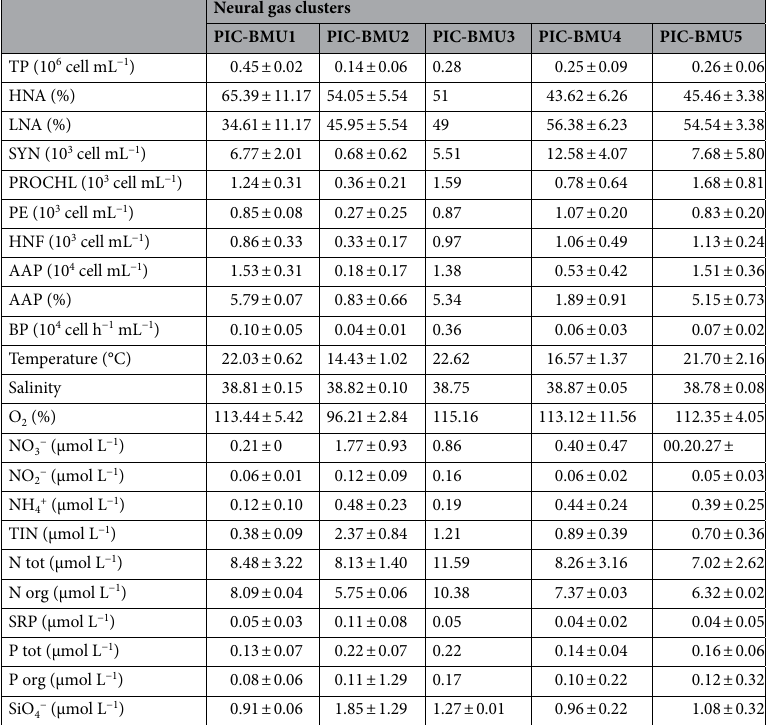
Table 1. Characteristics of biological (abundances of total prokaryotes-TP, Synechococcus -SYN, Prochlorococcus -PROCHL, picoeukaryotes-PE, heterotrophic nanoflagellates-HNF, aerobic anoxygenic phototrophs(AAP); contributions (%) of AAP, High nucleic acid content bacteria-HNA and Low nucleic acid content bacteria-LNA%; and bacterial production-BP) and environmental factors in the sampling terms assigned to the neural gas clusters. Mean values ± standard deviation from all the samples cluster in a PIC- BMU are